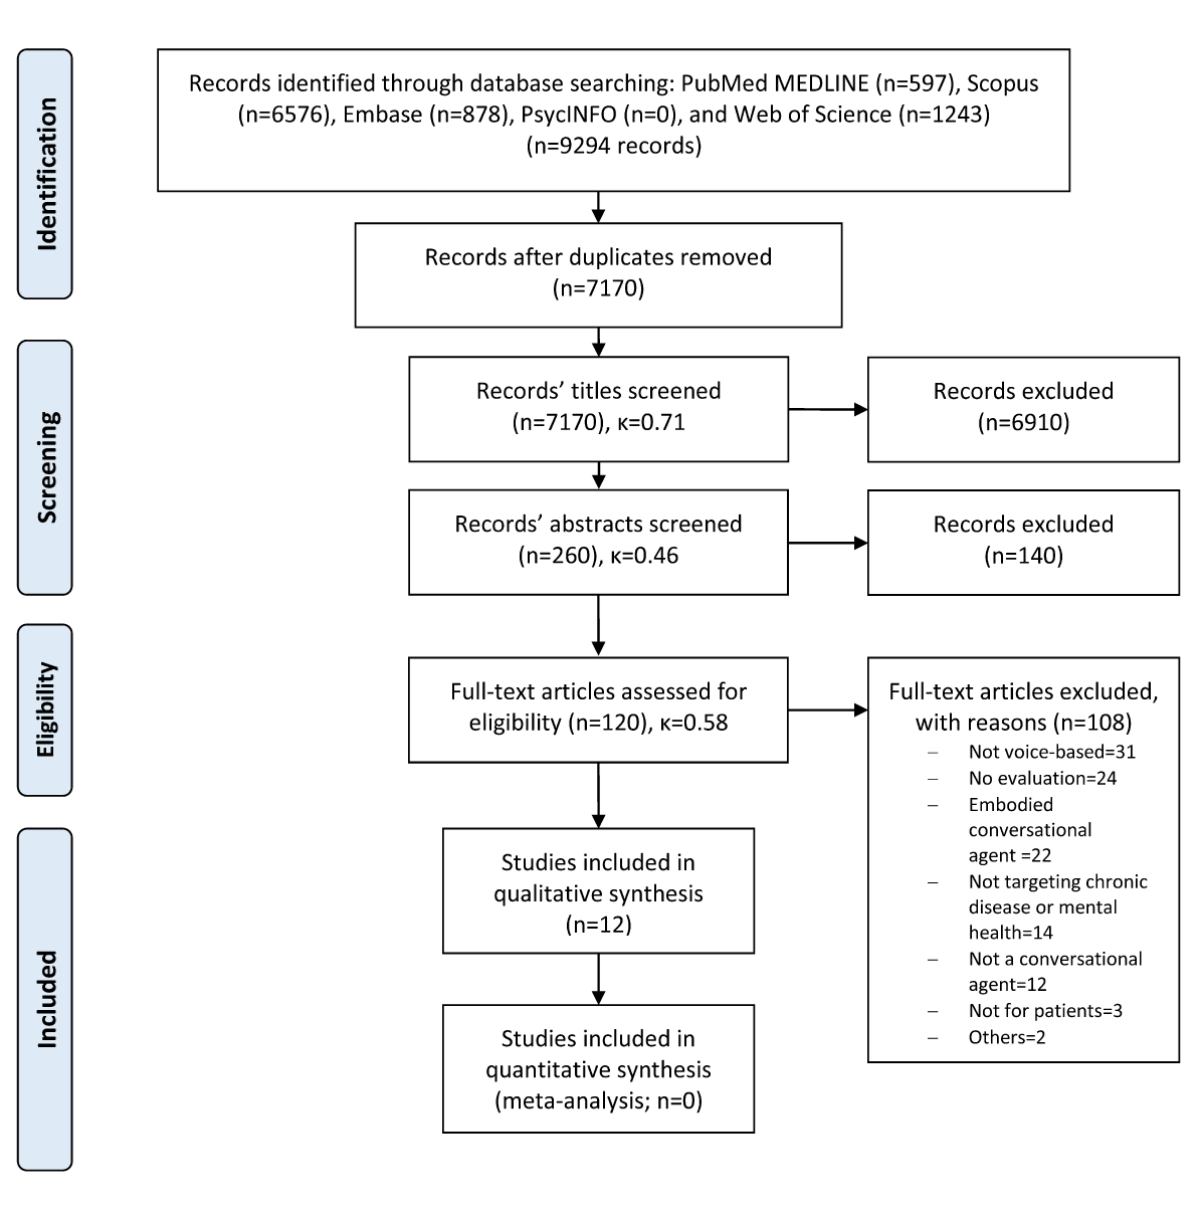
Figure 1. PRISMA (Preferred Reporting Items for Systematic Reviews and Meta-Analyses) flow diagram of included